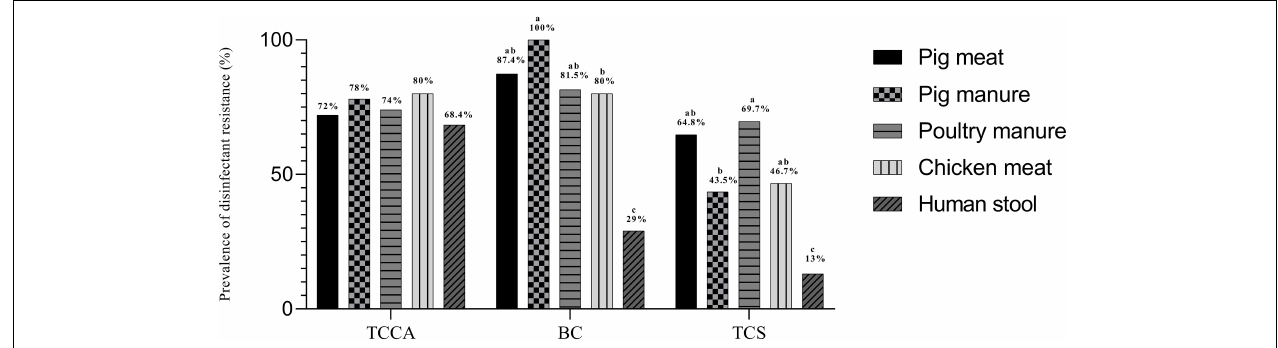
FIGURE 5 | Prevalence of disinfectant resistance among Salmonella Typhimurium isolates from pig meat, pig manure, poultry manure, chicken meat, and human stool. Different lowercase letters indicate statistically significant differences between groups ( P < 0.05).